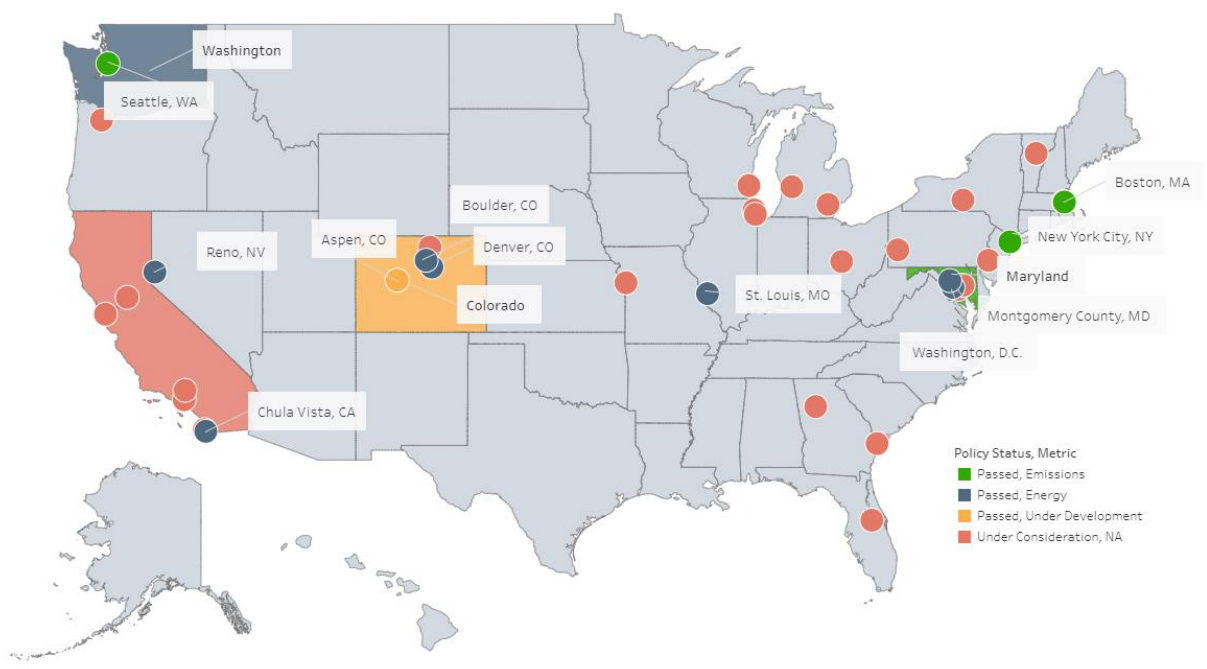
Figure 5. BPS status in the U.S. [99]. Reproduced with permission from Battelle Memorial Institute, 2022.